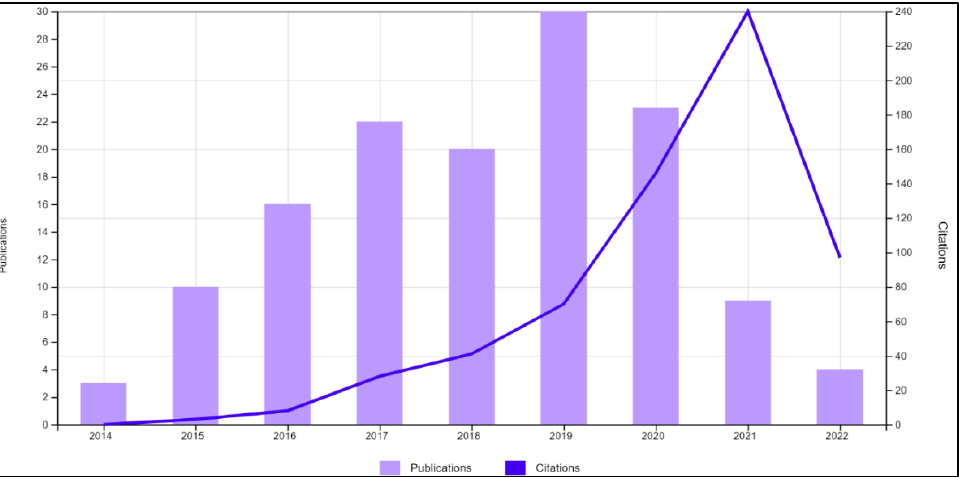
Figure 10. An overview of publications and citations on the topic of Smart cities in Czechia. Source: own analysis as per Web of Science (2022).